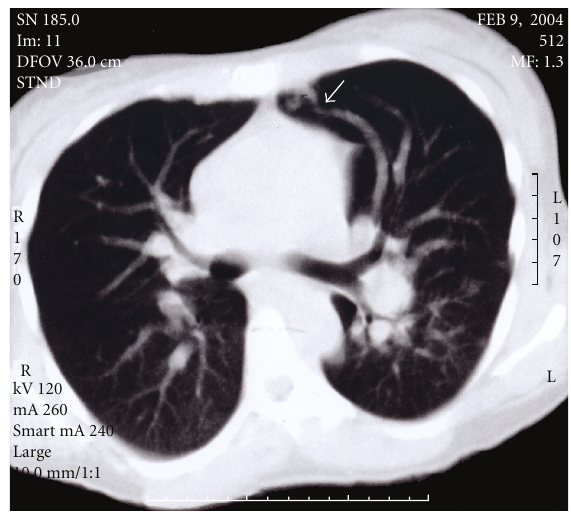
Figure 1: Axial computerized tomography of the chest in lung window demonstrating a feeding artery and a draining vein to a nidus of an arteriovenous malformation (arrowhead).